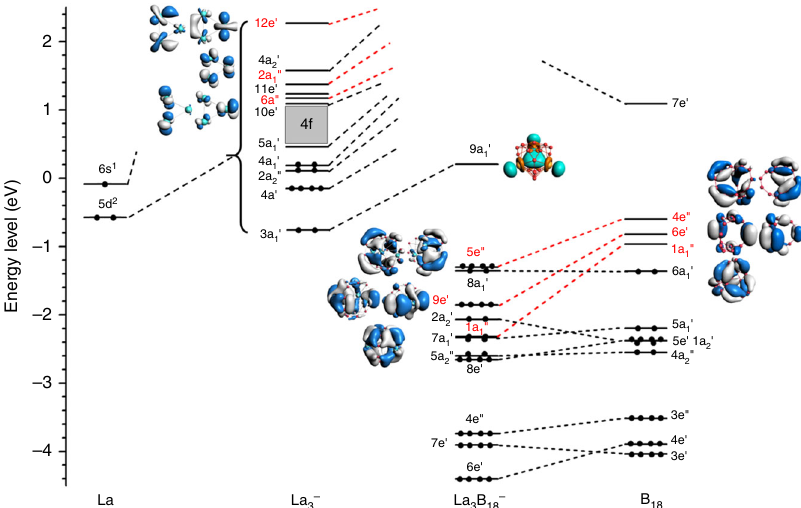
Fig. 4 The Kahn – Sham molecular orbital correlation diagram for La 3 B 18 – ( D 3 h , 1 A 1 ). It shows the interactions between the 5 d orbitals of the three La atoms and the group orbitals of the B 18 B sp characters. Because La 3 B 18 – has a closed-shell con fi guration, single-electron removal from each molecular orbital (MO) yields one detachment channel, as shown in Supplementary Table 1.